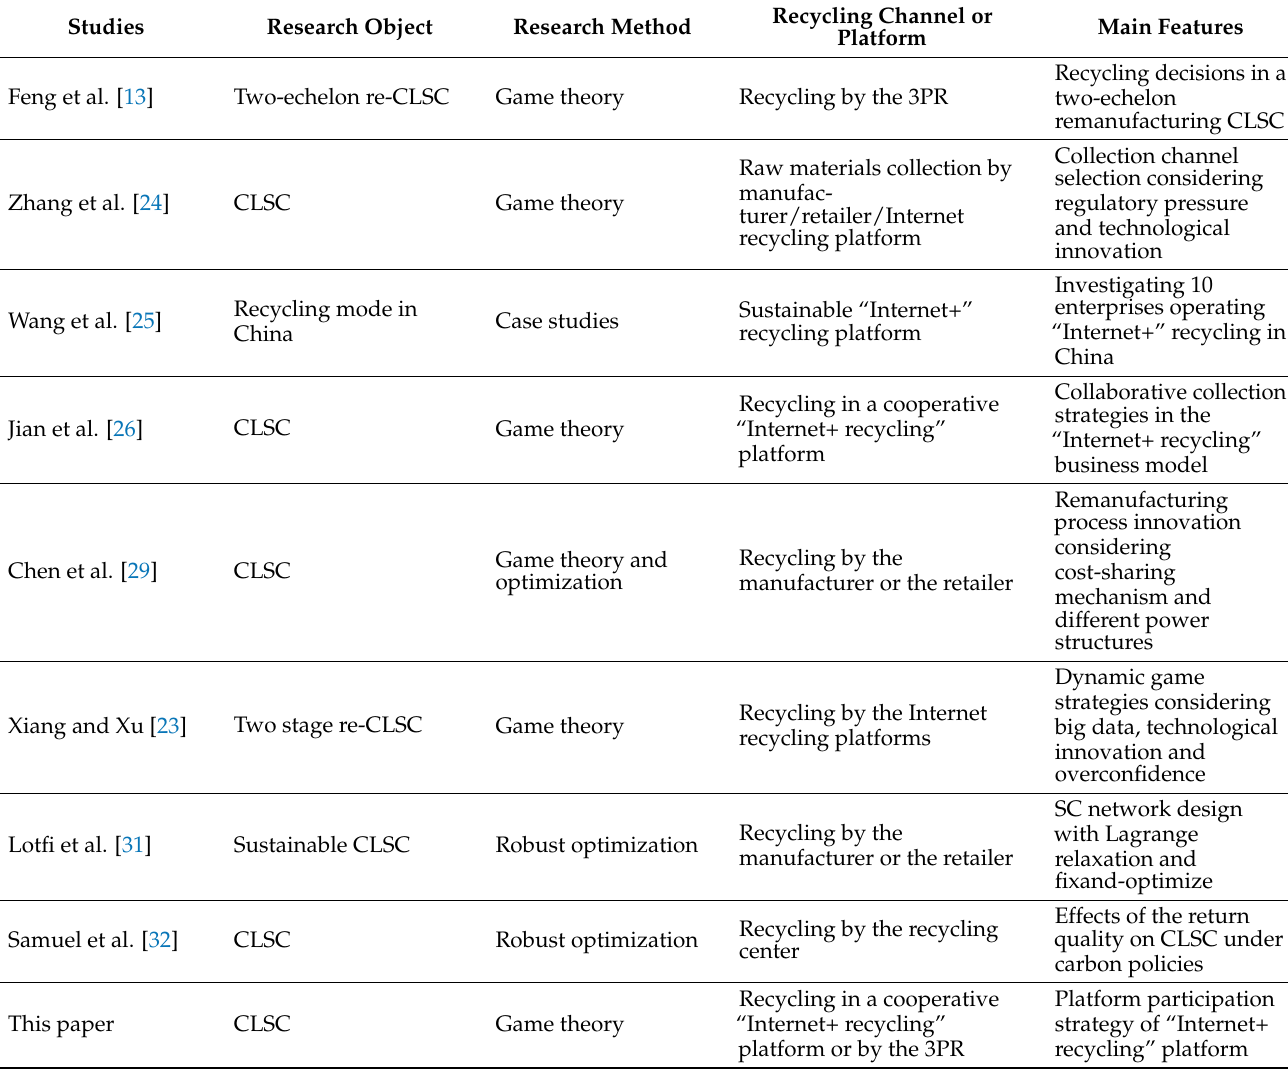
Table 1. Comparison of this study and related